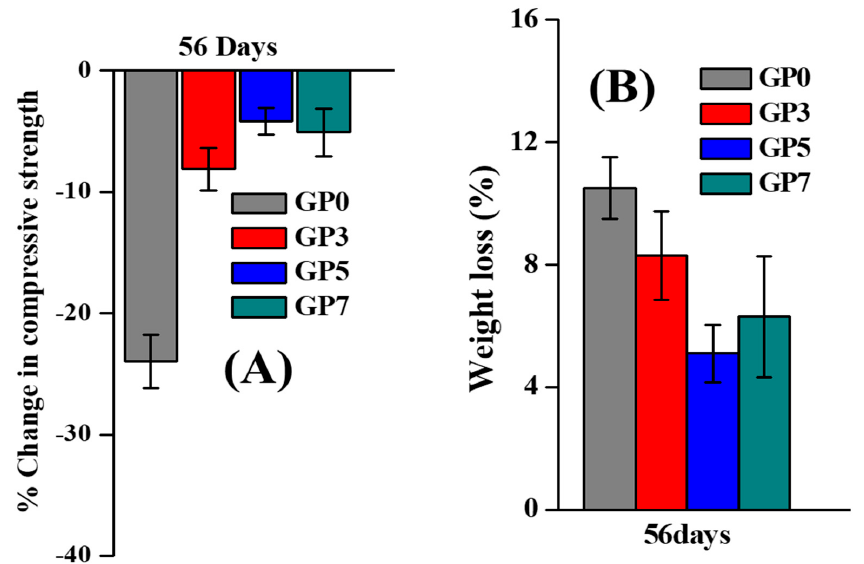
12 of 22 Figure 8. ( A ) Color changes at different temperatures in all the geopolymer specimens: GP0 to GP7 specimens (left to right, respectively); ( B ) fracture pattern. 3.5. Freeze-Thaw Effect A freeze-thaw test was conducted to evaluate the durability of the geopolymer specimens. The compressive strength of all the geopolymer specimens decreased after the freeze-thaw test (Figure 9A). The residual compressive strength of the GP0 specimen was found to be the lowest, as compared with the other specimens after 25 freeze-thaw cycles. It was observed that increasing fiber contents in the geopolymer matrix increased the freeze-thaw resistance. The strength values of GP3, GP5, and GP7 geopolymer specimens dropped to about 8%, 4.18%, and 5.1%, respectively, after the same